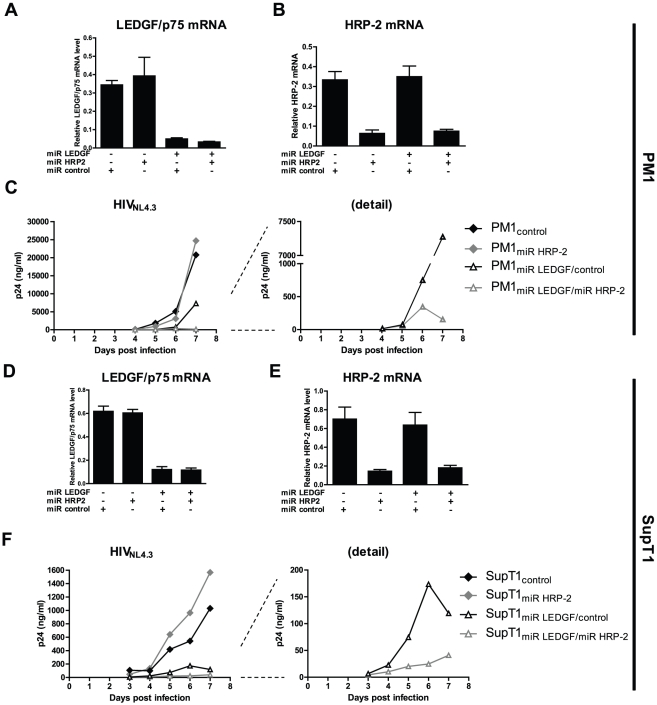
HRP-2 KD additionally hampers HIV-1 replication in LEDGF/p75 KD cell lines.Stable LEDGF/p75 and/or HRP-2 KD and control PM1 and SupT1 cells were generated. In (A) qPCR results for LEDGF/p75 and (B) HRP-2 mRNA expression levels, normalized to RNaseP for PM1 are shown. Average with standard deviations from experiments in triplicate, are shown. The constructs used, are shown below the graph. (C) Multiple round HIV-1 replication after challenge with the laboratory strain HIVNL4.3. On the right a detail panel for LEDGF/p75 KD cells is shown. In (D) LEDGF/p75 and (E) HRP-2 expression levels in SupT1 cells, analogous to (A) and (B) are shown. (F) Multiple round HIV-1 replication in the different SupT1 cells, analogous to (C), is shown.